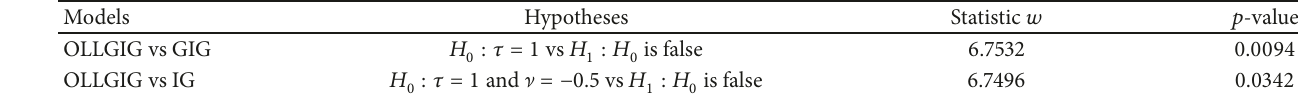
Table 6: LR tests for the iris